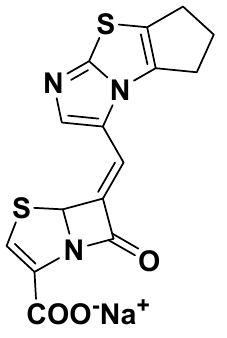
Figure 4. Chemical structure of 6-(6,7-dihydro-5H-cyclopenta[d]imidazo[2,1-b]thiazol-3- ylmethylene)-7-oxo-4-thia-1-aza-bicyclo [3.2.0] hept-2-ene-carboxylate, sodium salt. The chemical structure was drawn using the ChemDraw Ultra 7.0 software (Chem Office 2002).